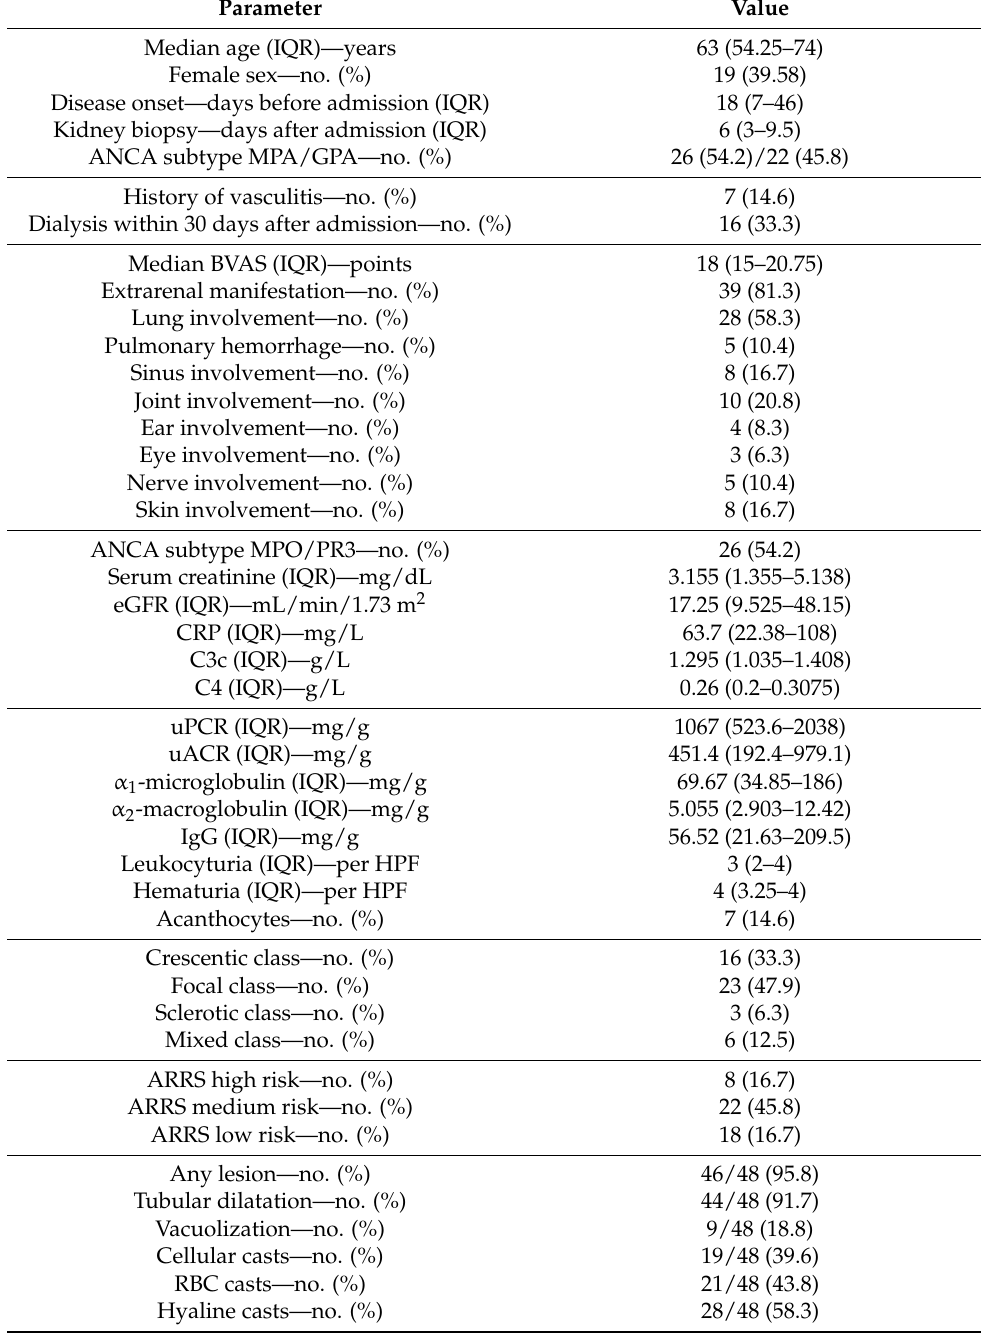
Table 1. Clinical and laboratory parameters of the total ANCA GN